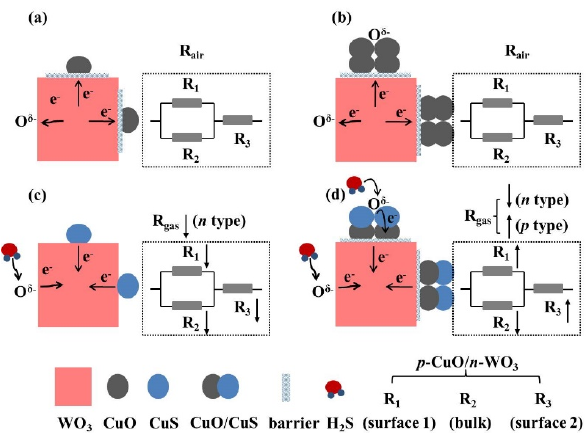
Figure 10. Schematic diagrams of the CuO / WO 3 microstructure. In air: ( a ) low CuO content and ( b ) high CuO content. In H 2 S: ( c ) low CuO content and ( d ) high CuO content.